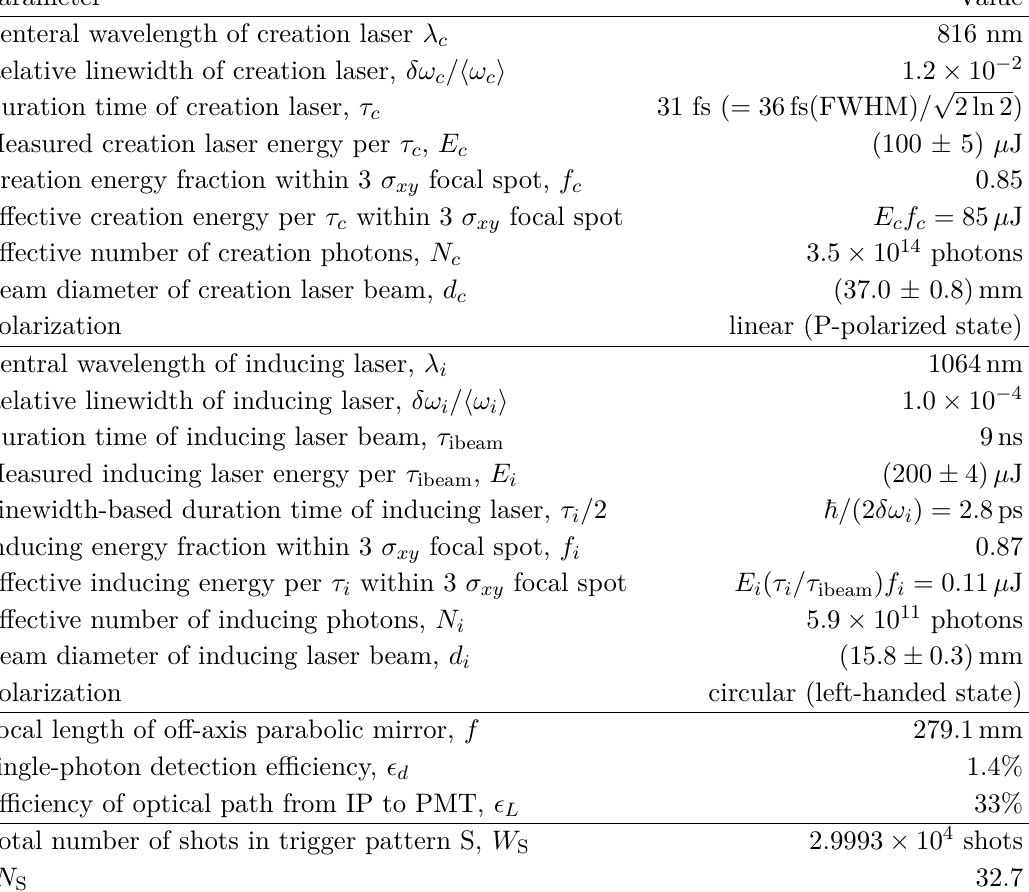
Table 1 . Experimental parameters used to numerically calculate the upper limits on the coupling- mass relations. The effective numbers of photons, N c and N i , were used for the limit calculations. only possible process in the standard model, is negligibly low at E